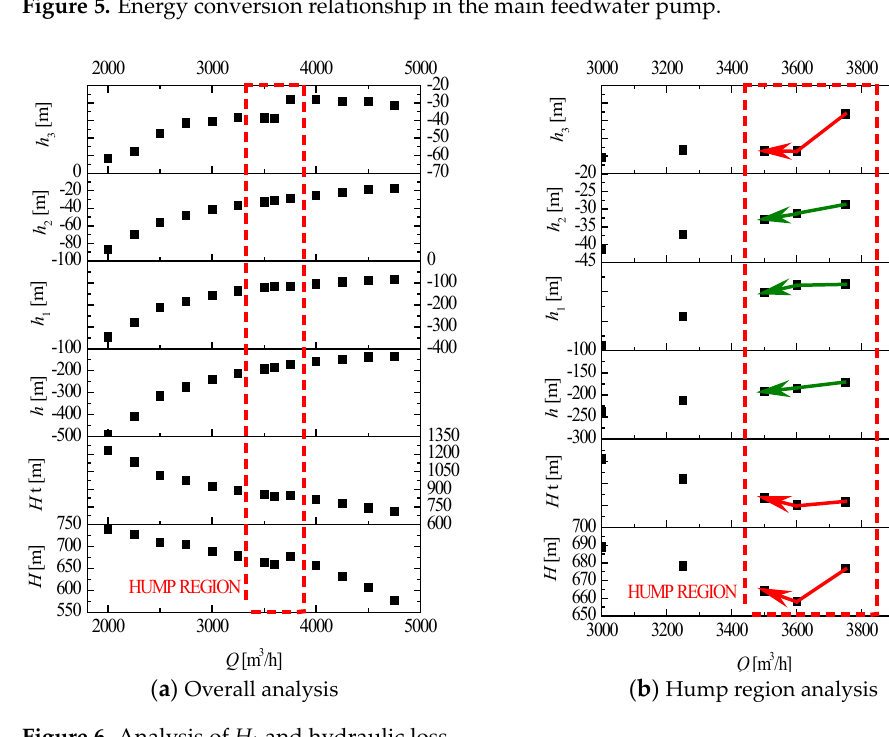
ABNORMAL BLADES Figure 7. Distribution of impeller blade capacity for work. 3.2. Analysis of Changes in Impeller Capacity for Work The external characteristic is the macroscopic manifestation of flow in the pump, so the hump formation mechanism can be revealed by analyzing the microscopic flow field. By comparing the flow pattern in the pump under the peak and valley condition, an ob- vious difference in the flow pattern is found in the diffuser. Figure 8 expands the internal flow field and pressure field in the diffuser in the cascade form, where 1 to 12 represent the diffuser blade number, and 0.1 to 0.9 represent different blade spans. Under the peak condition, the streamline is smooth, while with stall, namely large flow separation occurs